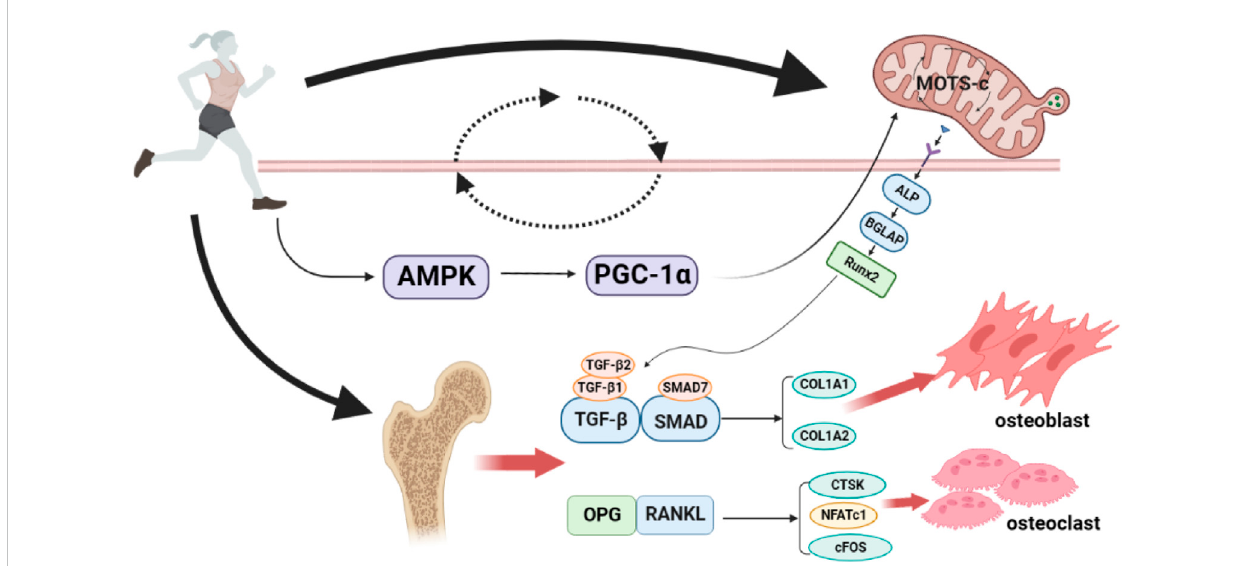
Potential pathways of exercise to promote bone metabolism through MOTS-c. Exercise can increase the expressionof MOTS-c, thus activating the co-activator AMPK, resulting in an increase in PGC-1 α , which in turn increases the expression of the mitochondrial-derived peptide MOTS-c, forming a loop that may regulate the expression of osteoblast/osteoclast-related genes, and ultimately, the osteoblast-osteoclast balance. AMPK, AMP-activated protein kinase; PGC-1 α , Peroxisome proliferator-activated receptor- γ co-activator-1 α ; ALP, Alkaline phosphatase; BGLAP, bone γ - carboxyglutamate protein; Runx2, Runt-related transcription factor 2; TGF- β 1, transforming growth factor- β 1; TGF- β 2, transforming growth factor- β 2; SMAD7, Small mothers against decapentaplegic7; COL1A1, Collagen type I alpha 1; COL1A2, Collagen type I alpha 2; OPG, Osteoprotegerin; RANKL, nuclear factor- κ B ligand; CTSK, cathepsin K; NFATc1, activated T Cells c1; cFOS, pleiotropic transcription factor. Produced using Biorender